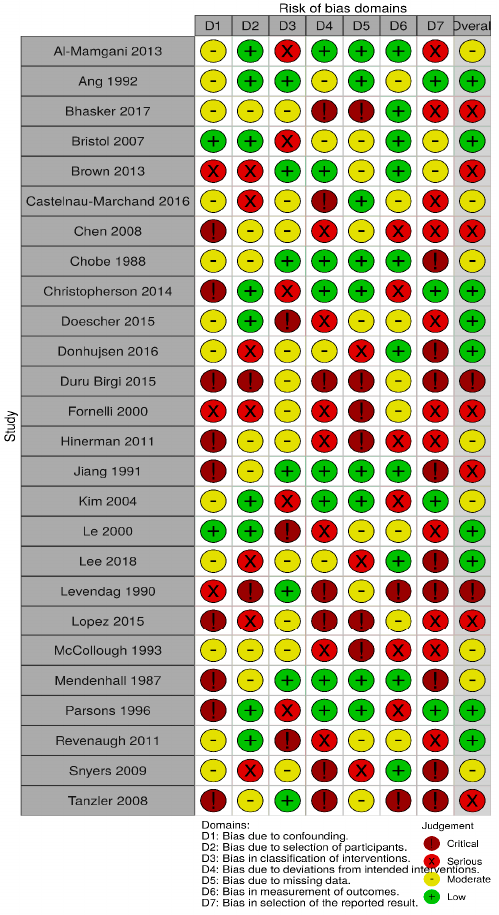
Figure 4. A “traffic light” plot of the domain-level judgements for each individual result.